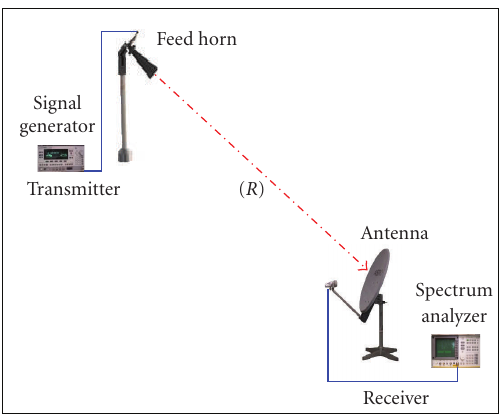
Figure 1: Experiment system